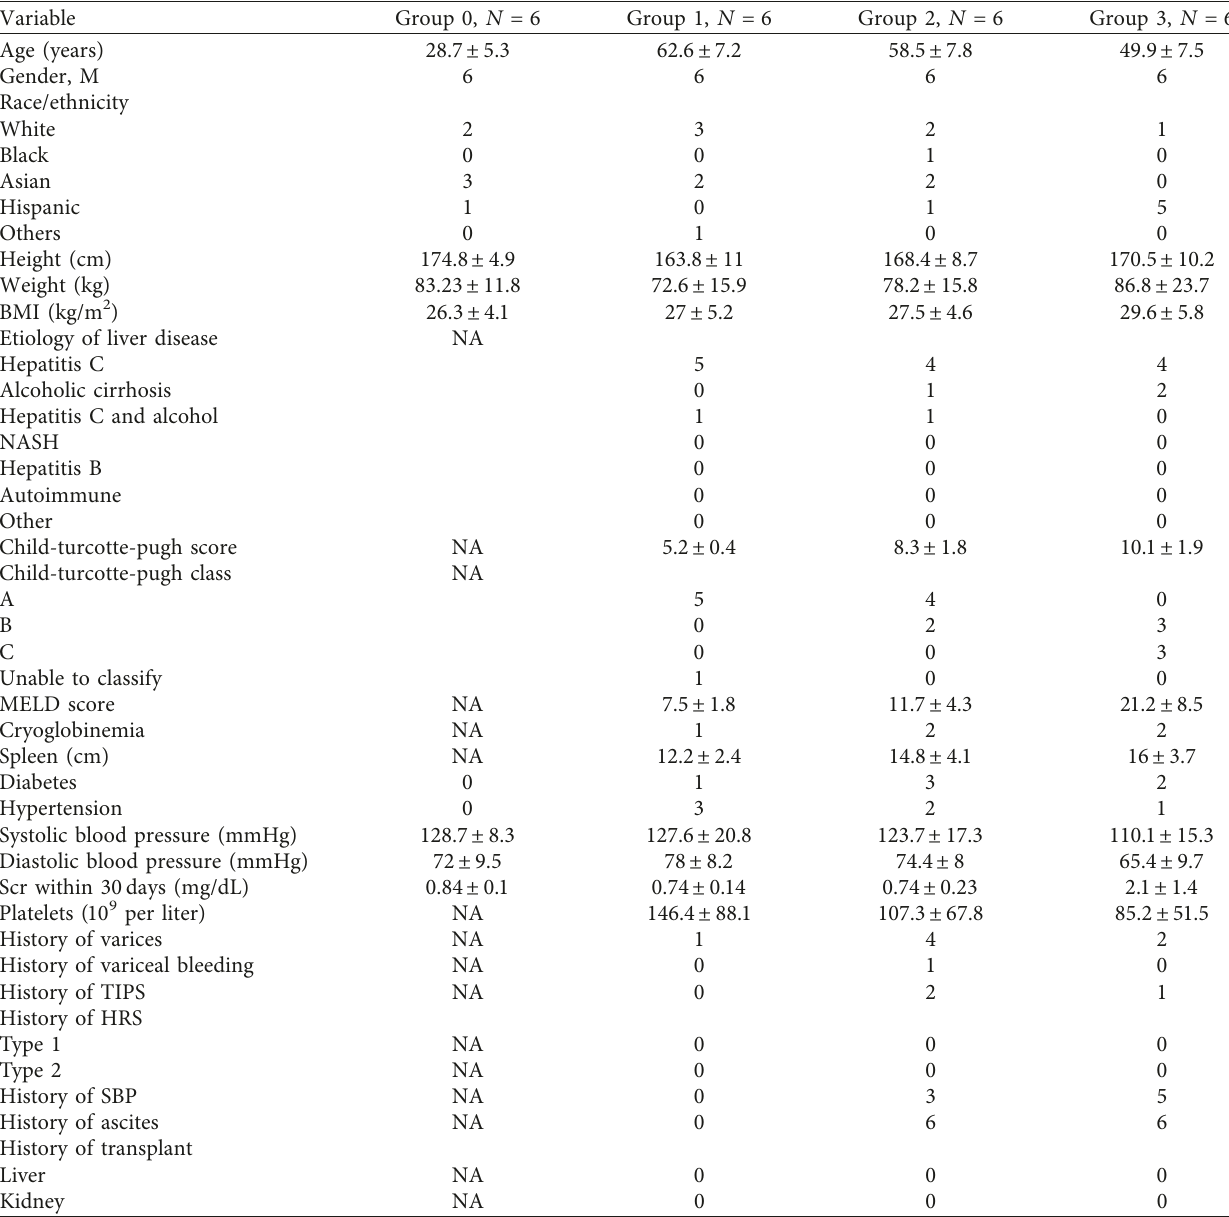
Table 1: Study subject